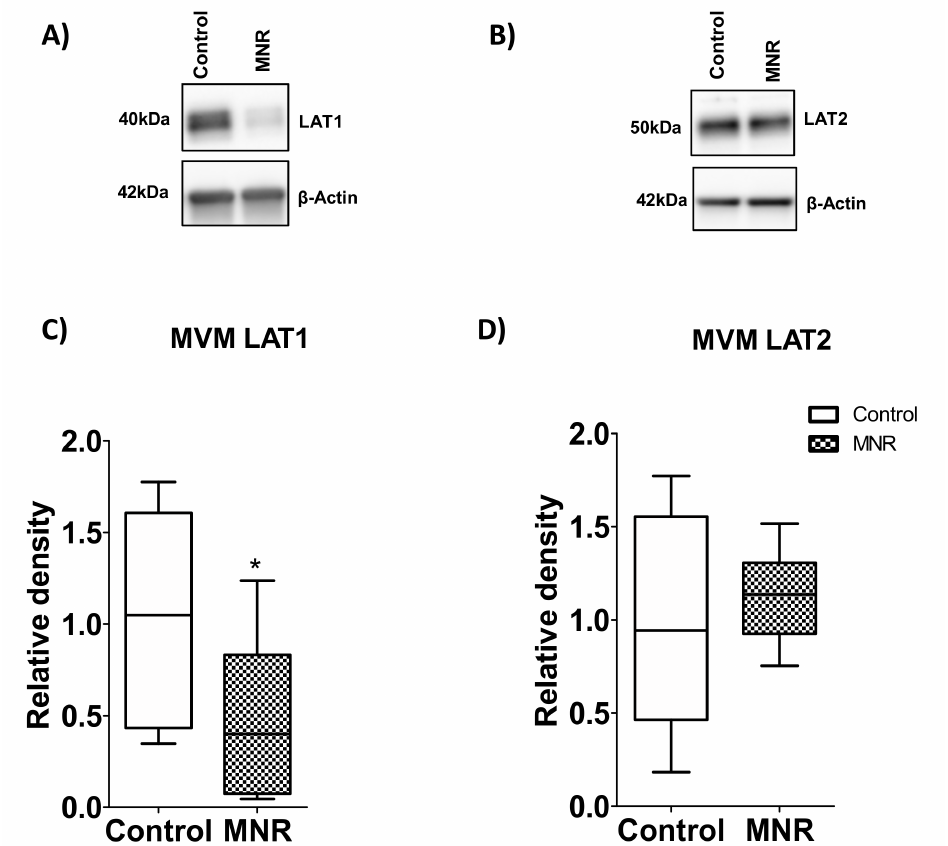
Figure 8. ( C , D ) MVM LAT1 and 2 protein expression. Western blot analysis of ( A ) LAT1 and ( B ) LAT2 (system L amino acid transporter isoforms) in MVM isolated from control ( C ) and MNR baboons at GD 140. The histogram shows protein expression data of MVM LAT1 and LAT2. Equal sample loading was performed. After normalization of MVM LAT1 or LAT2 expression to loading control ( β -actin), the average density of the control sample band was designated an arbitrary value of 1. Values are given as Medians ± IQR. * p < 0.05, Mann–Whitney test (n = 9/each group). KS normality test p -value: MVM LAT1 (Control, p > 0.10; MNR, p > 0.10; passed normality), MVM LAT2 (Control, p > 0.10; MNR, p > 0.10; passed